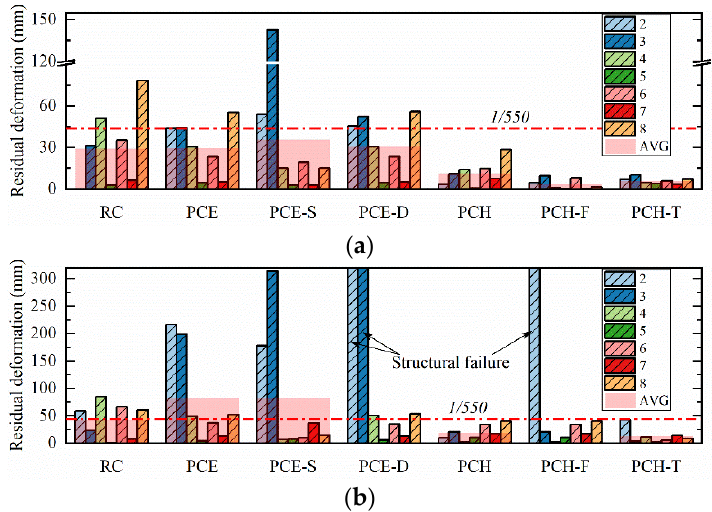
Figure 17. Residual deformation at top floor of various structures: ( a ) under rare earthquakes; ( b ) under extremely rare earthquakes.